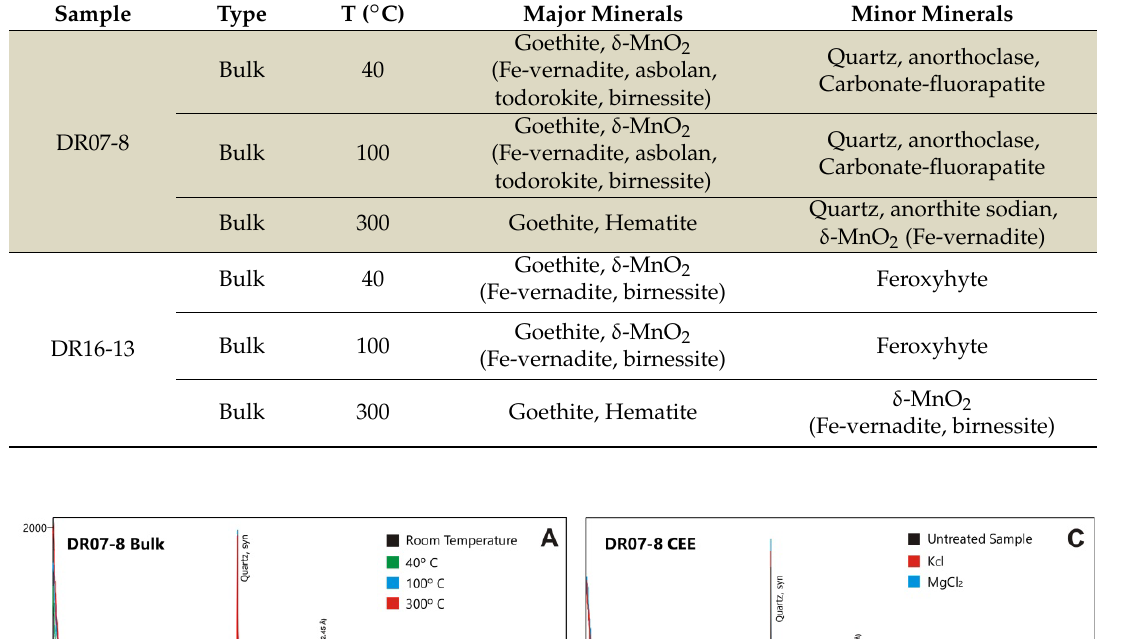
Table 1. XRD mineralogy of crystalline phases from CISP Fe–Mn crusts DR07-8 and DR16-13. Major > 25%; Minor < 10%. The back color is to differentiate both